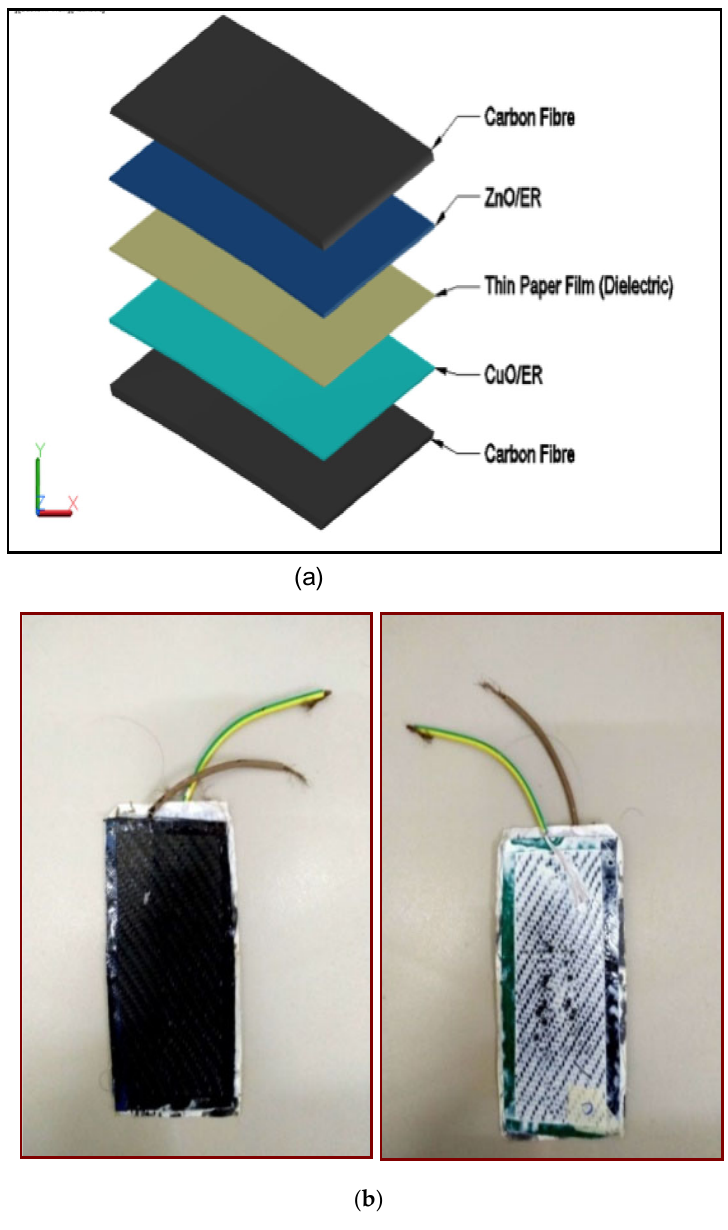
Figure 2. Sample of solar supercapacitor ( a ) exploded view and ( b ) prototype units.